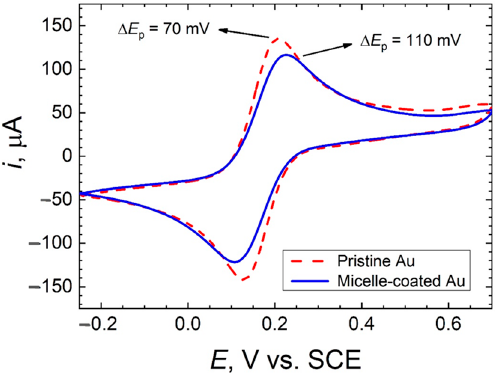
Figure 3. Cyclic voltammogram for pristine and micelle modified gold in 0.1 M KCl + 1 mM K 3 Fe(CN) 6 . Scan rate: 20 mV s − 1 ; Area: 0.5 cm 2